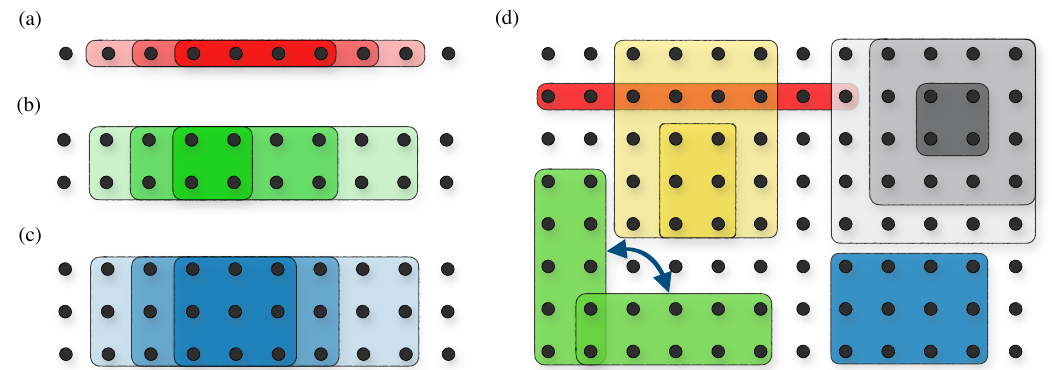
Figure 1: Examples of clusters which are used in the NLCE. (a) For a chain geometry, all clusters and subclusters are chains. (b) and (c) In case of a ladder geometry, we only consider clusters and subclusters which are ladders as well. (d) For the two- dimensional square lattice, we restrict ourselves to clusters with a rectangular shape. Given the Hamiltonian in Eq. (1), we note that a cluster c = ( x , y ) with x > y is H equivalent to its 90 ◦ -rotated counterpart c (cid:48) = ( y , x ) . To speed up the simulations, we therefore only need to consider clusters c with x ≥ y , where square-shaped clusters with x = y enter Eq. (6) once, while rectangular clusters with x > y enter the expansion